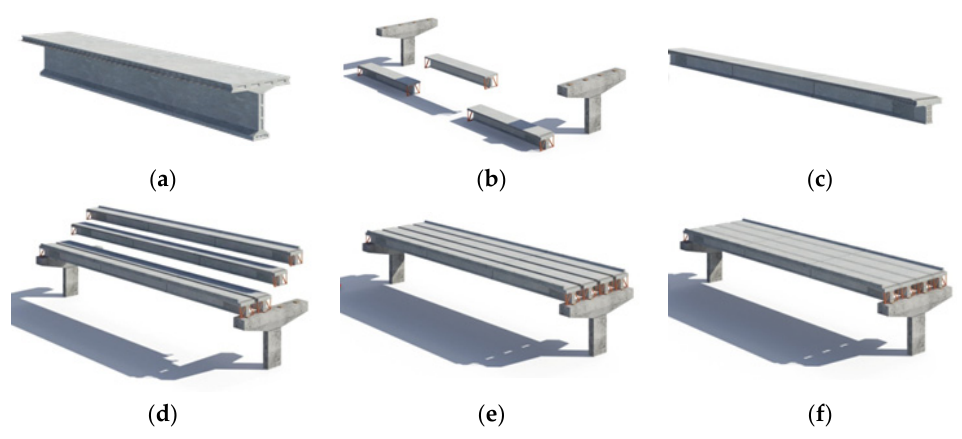
Figure 1. Concept of a modular bridge: ( a ) Standard module fabrication. ( b ) Module transport. ( c ) Longitudinal module connection with prestressing. ( d ) Module setting. ( e ) Transverse lap splice. ( f ) Cast ‐ in ‐ place joint.